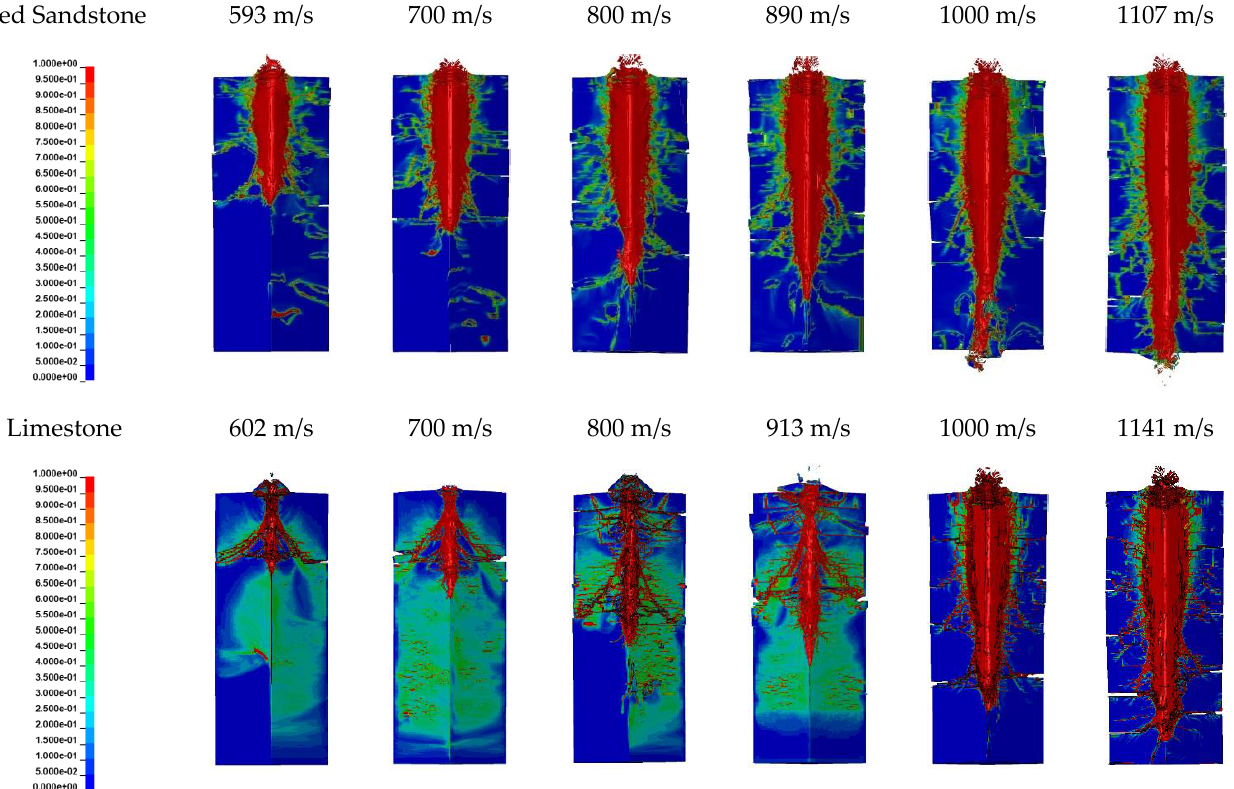
Figure 10. Distribution of internal cracks in limestone after penetration at different speeds.